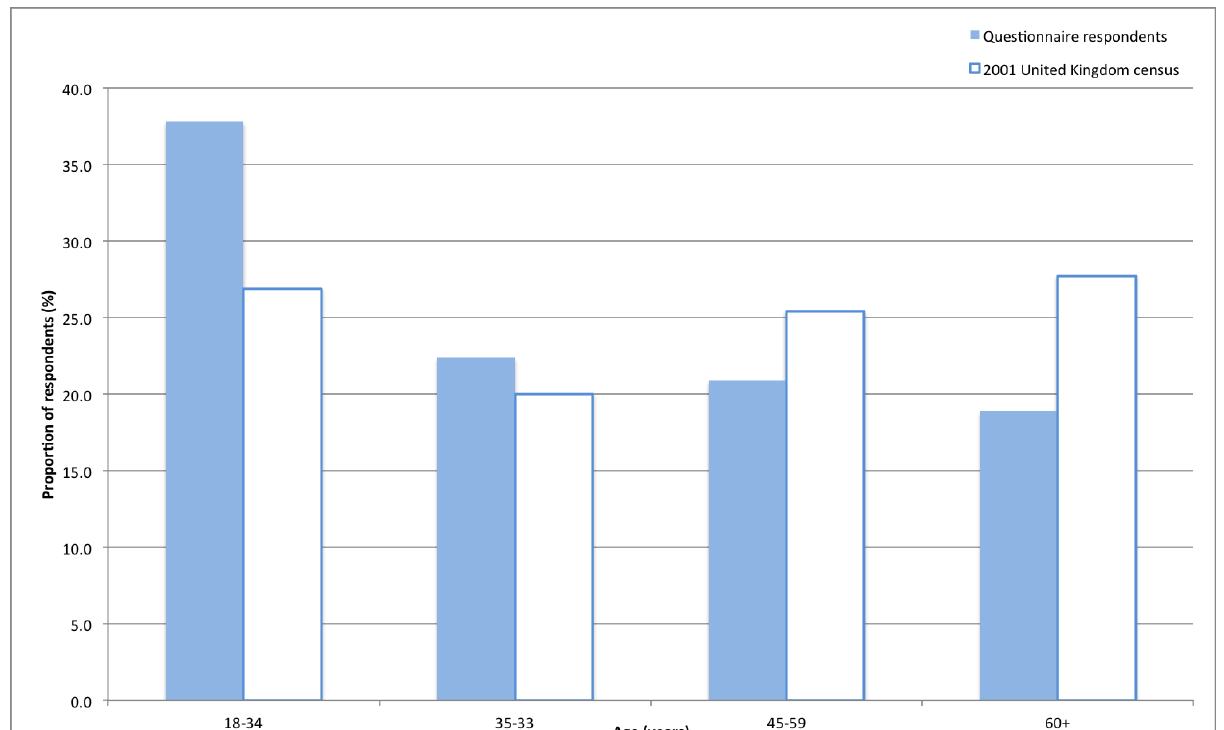
Figure 1. Age spread of questionnaire respondents compared with 2001 United Kingdom census